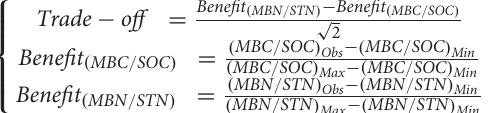
FIGURE 3 | Count distributions of (A) soil microbial biomass carbon (MBC), (B) soil microbial biomass nitrogen (MBN), and (C) the ratio of soil microbial biomass carbon to nitrogen (MBC/MBN) across alpine steppe and meadow. “Mean” and “CV” represent the average values and coefficients of variation of MBC, MBN, and MBC/MBN, respectively. And P -values indicate level of significant differences of MBC, MBN, and MBC/MBN between alpine steppe and alpine